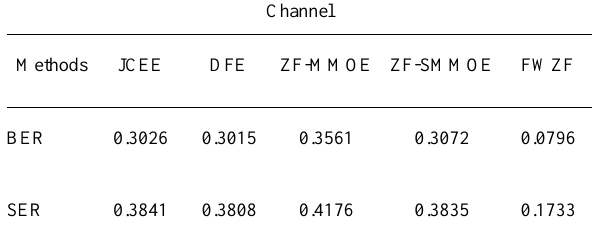
Table 3. Comparative discussion using the ZF methods in Rician